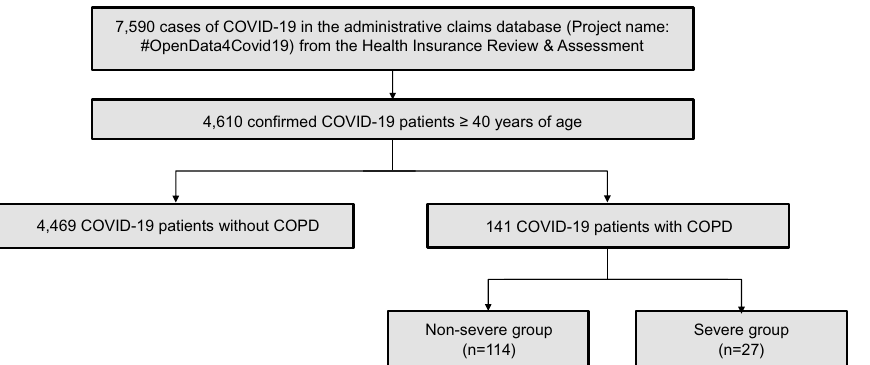
Figure 2. Flowchart of the study cohort. Of 7590 COVID-19 patients, 4610 were aged 40 years or older. During the enrollment period, 4469 and 141 patients were categorized into the non-COPD and COPD groups, respectively. Among the COPD patients, 114 and 27 were classified into the non-severe and severe groups, respectively. COPD was defined by the ICD-10 codes and COPD medications prescribed during the enrollment period. The severity of COPD was classified based on the types of medications prescribed and the number of exacerbations during the measurement period. COVID-19 coronavirus disease 2019; COPD, chronic obstructive pulmonary disease; ICD-10, 10th revision of the International Statistical Classification of Diseases and Related Health